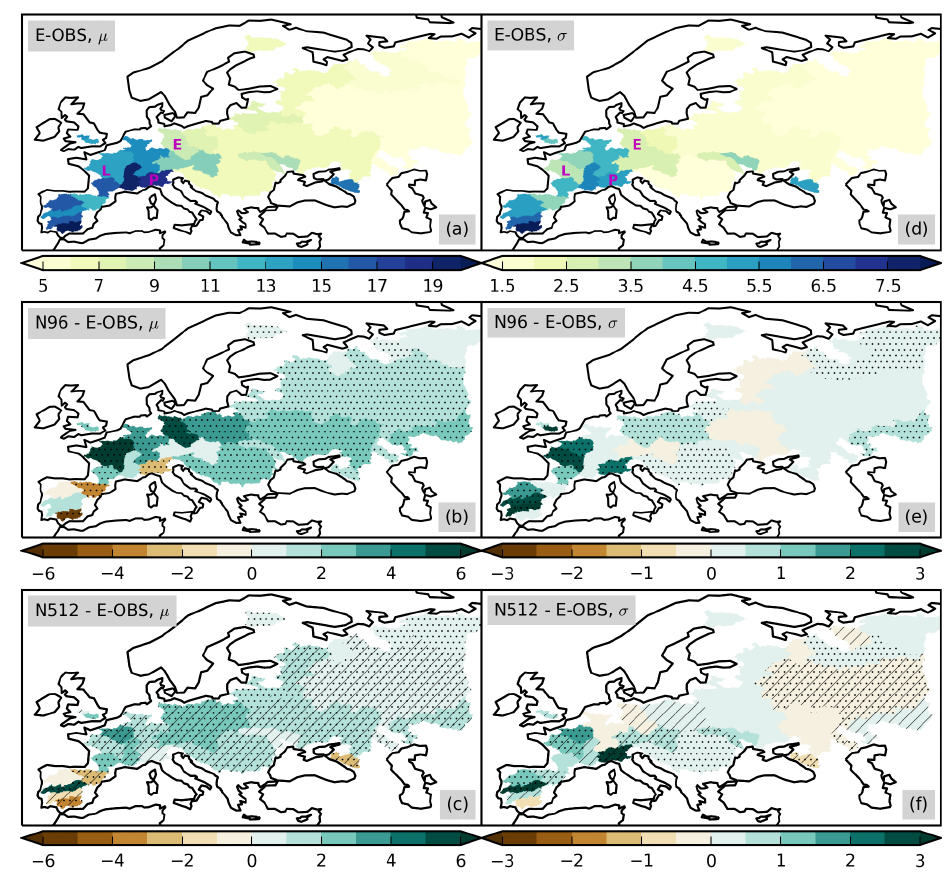
Figure 5. Estimated GEV parameters for December–February daily basin-average precipitation: (a–c) location parameter µ and (d–f) scale parameter σ , both in mmday − 1 , and for (a, d) observations (E-OBS), (b, e) N96 bias, and (c, f) N512 bias with respect to E-OBS. Stippling (hatching) shows statistically significant differences between the models and E-OBS (between N512 and N96). Letters L, E, and P show the Loire, Elbe, and Po basins.